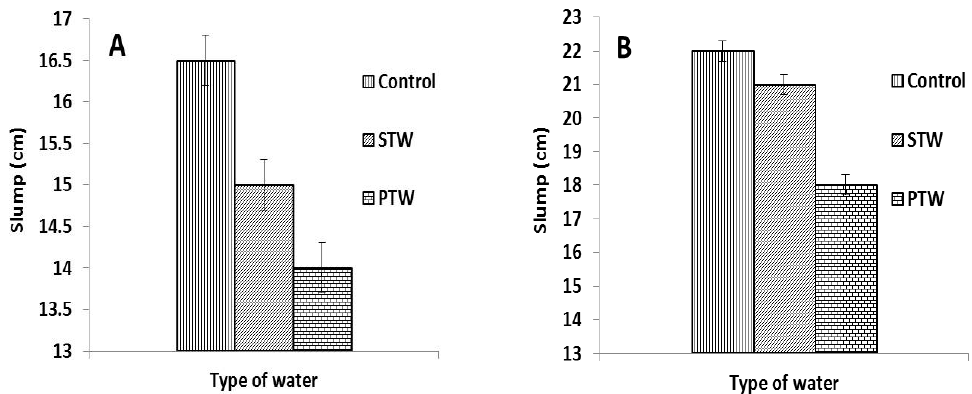
Figure 5. Slump of concrete using PTW, STW, and Control as mixing water. ( A ): Lab scale mixtures; ( B ): scale up mixtures to ready mix concrete.